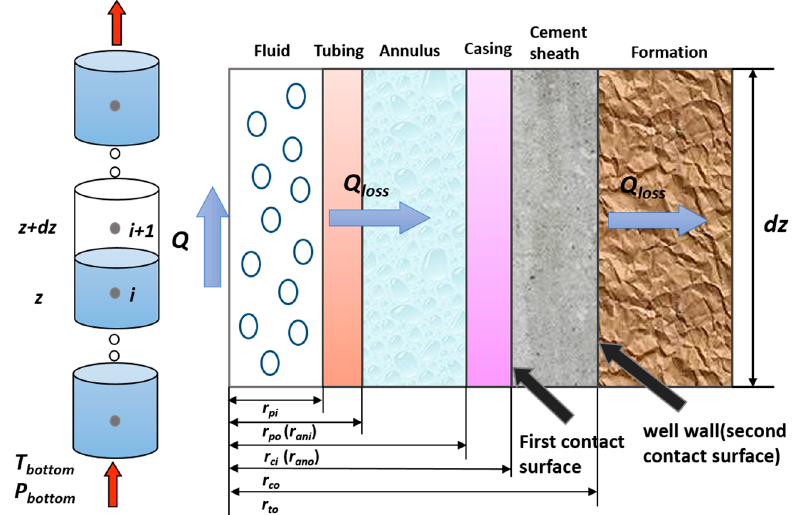
Figure 2. Schematic of wellbore heat transfer.